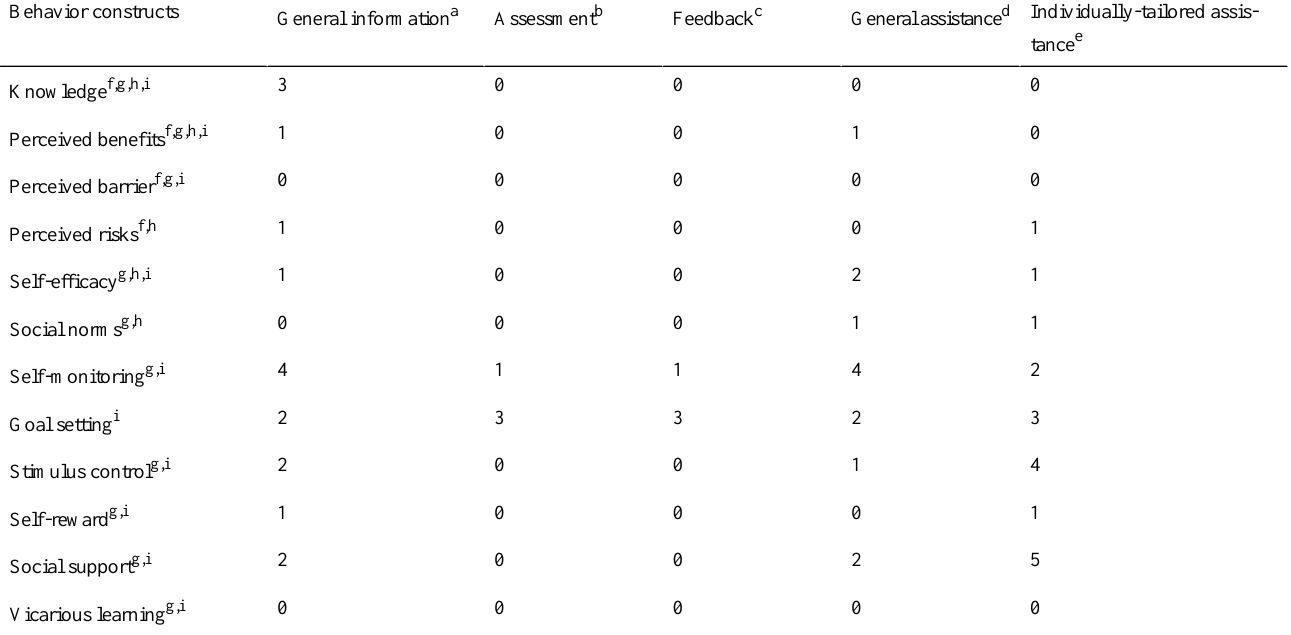
Table 1. Theory integration in selected calorie counting apps